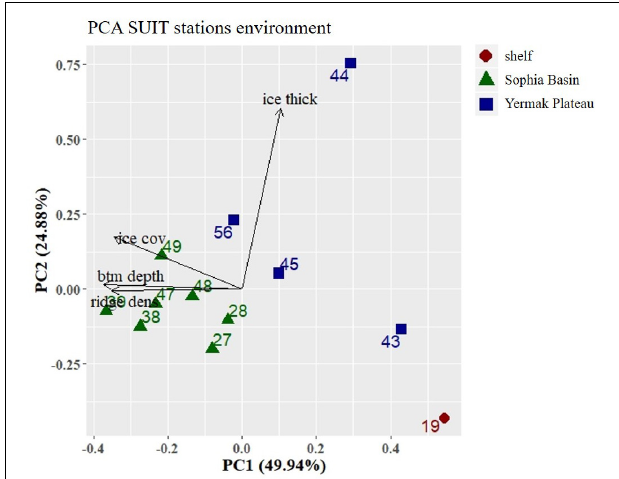
FIGURE 6 | Principal Component Analysis (PCA) plot of environmental parameters at the SUIT stations. Stations were color coded according to geographical regions (shelf, Sophia Basin, and Yermak Plateau). Black arrows point into the direction of increasing values of environmental parameters in the ordination. Percentage values in axis annotations indicate the proportion of explained variance of the PCA. Ice thick, ice thickness; ice cov, ice coverage; btm depth, bottom depth; ridge dens, ridge